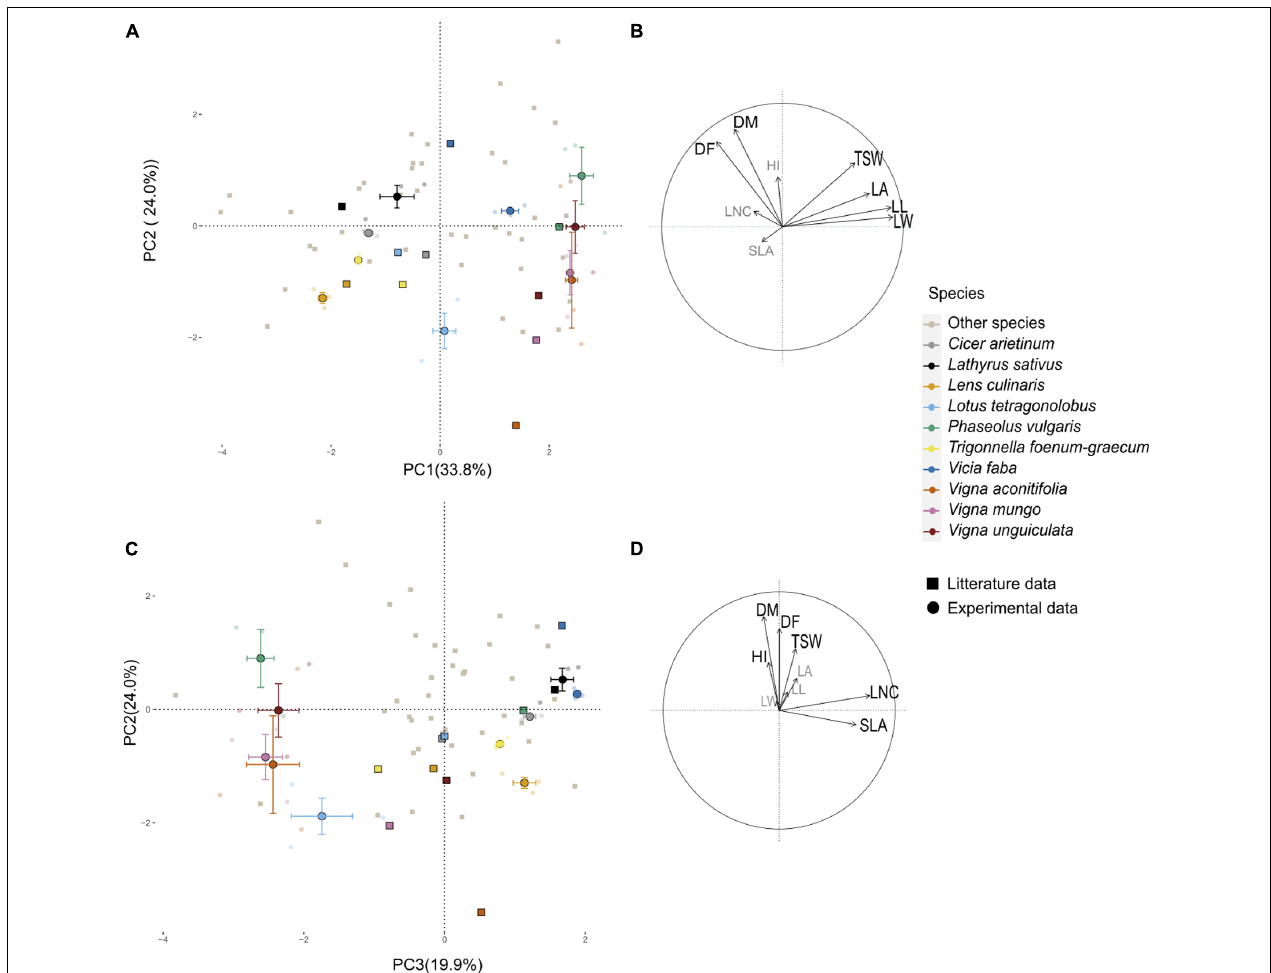
FIGURE 1 | Principal component analysis (PCA) performed on nine functional traits collected on 43 pulses species. (A,C) Individual species projection on the first three axes of the PCA; light gray points represent the 43 species from literature (Guiguitant et al., 2020) and colored points are from the current experimental study projected as supplementary individuals. Transparent points are the data of the four plots for the three varieties of the 10 species, the larger opaque points represent the barycenter of each species, and the horizontal and vertical bars represent the standard deviation along axes. Visualization of the variables and correlation circles on (B) PC1–PC2 and (D) PC2–PC3 planes. See Table 2 for abbreviations of